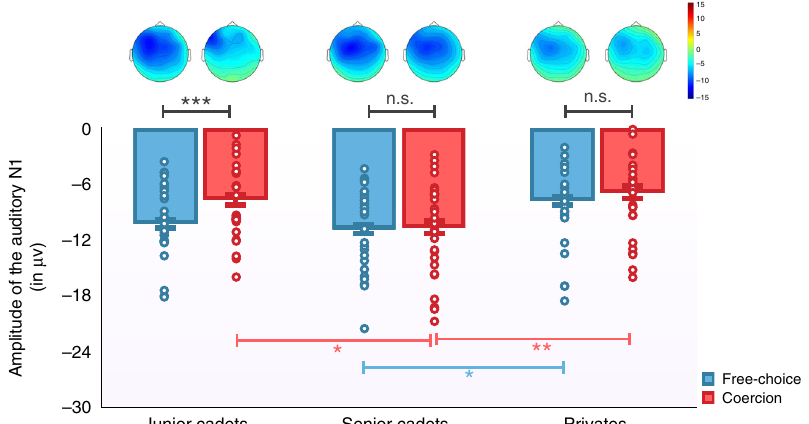
Fig. 4 Mean amplitude of the auditory N1 in both the free-choice (blue) and the coercion (red) conditions, respective to the Group (junior cadets – n = 28 vs. seniors – n = 30 vs. privates – n = 27). Data are presented as mean values ± SEM. Errors bars represent standard errors. Graphical display showing the interaction Condition*Group in a mixed ANOVA with independent (red, blue signi fi cance lines) and paired (black signi fi cance lines) sample t -tests. All tests were two-tailed. ** represents a p -value between 0.001 and 0.01. * represents a p -value between 0.01 and 0.05. n.s. indicates a non-signi fi cant result. The group of junior cadets had a signi fi cant difference between conditions ( p = 0.001). In the free-choice condition, the amplitude of the N1 was higher for senior cadets in comparison with privates ( p = 0.019). In the coercion condition, the amplitude of the auditory N1 was higher for senior cadets than for junior cadets and privates ( p = 0.019 and p = 0.005, respectively). Colored dots represent individual data. Source data are provided as a Source Data fi